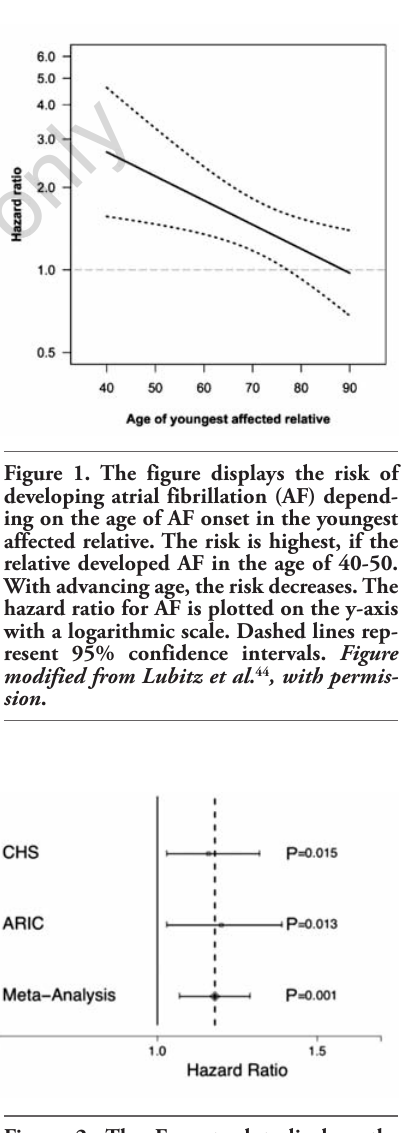
Figure 2. The Forrest plot displays the increased risk of atrial fibrillation (AF) in African Americans, depending on the European admixture. The meta-analysis showed a 17% risk increase per every 10% additional share of European descent, after multivariable adjustment. Figure modified from Marcus et al. 45 , with permission